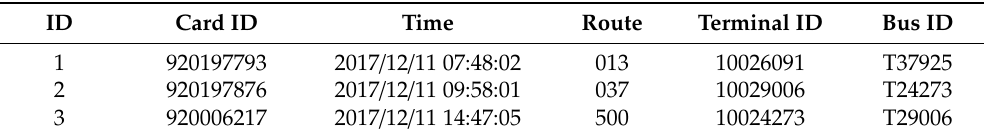
Table 2. Examples of the smart card data.